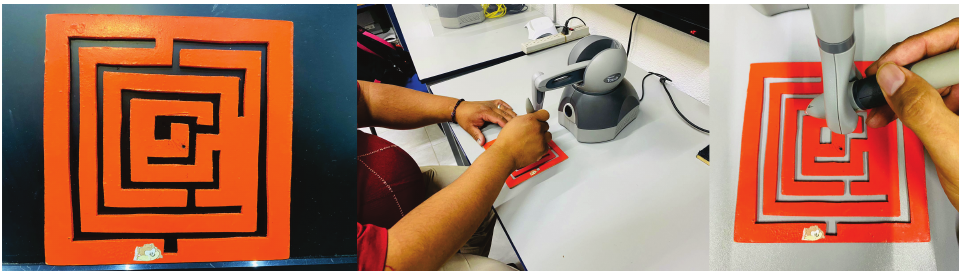
Figure 1. Patients under haptic guidance carrying out a maze task. These studies suggest that adaptability of the control strategy promotes rehabilitation evidence of motor